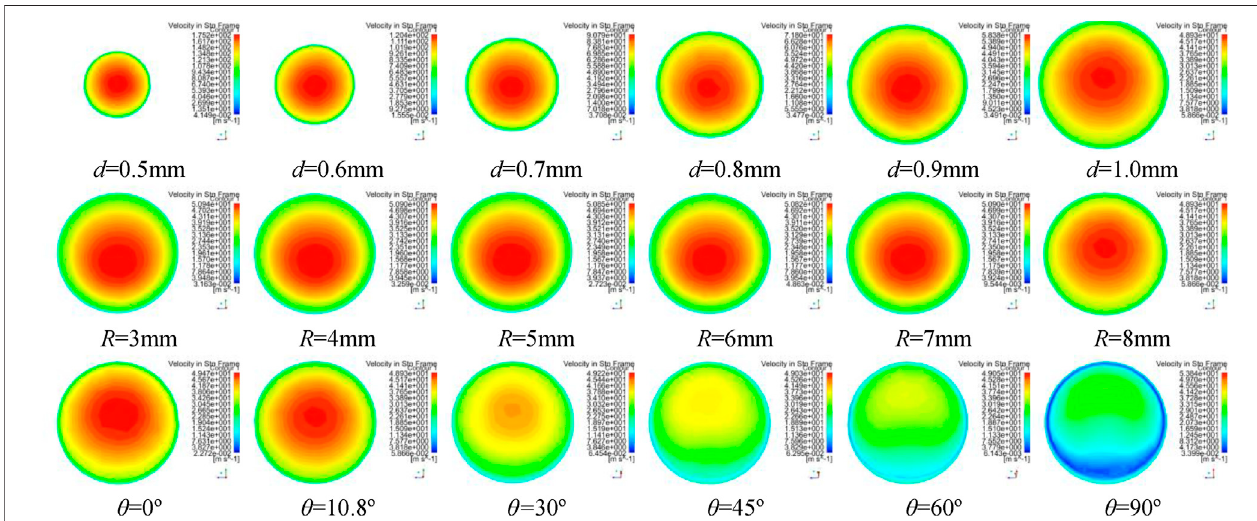
FIGURE 10 | The velocity contours of spinning solution in tube of curved-tube